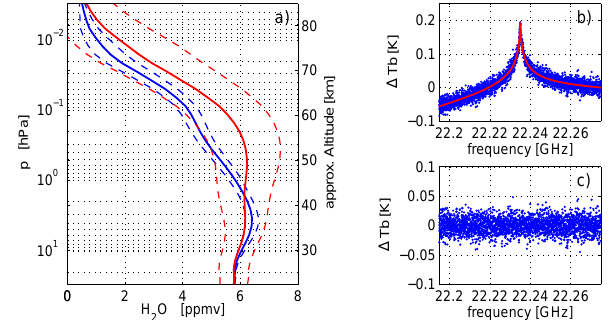
Fig. 4. (a) Example of MIAWARA-C retrieval for 21 March 2010 with a noise of 0.014K. The difference between the a priori profile (solid red; dashed red: a priori standard deviation) and the retrieved profile (solid blue; dashed blue: the estimated random error) is re- lated to the strong descent observed after the stratospheric sudden warming. (b) Measured and calibrated spectrum (blue) and spec- trum fitted by optimal estimation (red). (c) Residuals (difference between measured and fitted